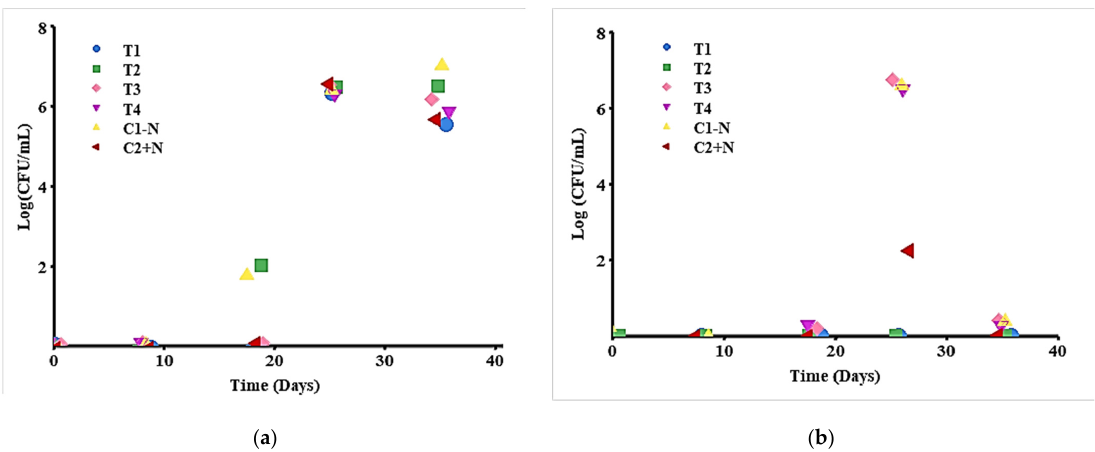
Figure 5. Microbiological characteristics of biopreserved T1–T4 chorizo and controls: ( a ) Microbiological count of molds and yeasts (PDA); ( b ) enteric microbiological count (MacConKey).